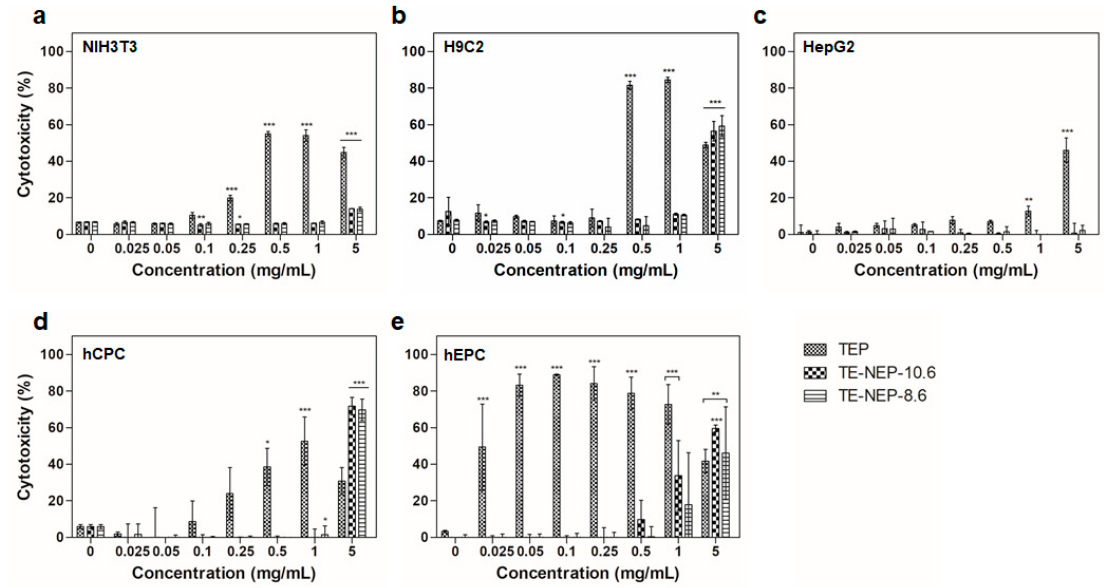
Figure 2. Evaluation of cell viability by MTT assay on ( a ) NIH3T3 cell line, ( b ) H9C2 cell line, ( c ) HepG2 cell line, ( d ) hCPC primary cell, ( e ) hEPC primary cell treated with Turmeric extract powder (TEP) and turmeric extract-loaded nanoemulsion powder with HLB values of 10.6 (TE-NEP-10.6) and 8.6 (TE-NEP-8.6), respectively. Cells were incubated with nanoemulsion samples (0.025, 0.05, 0.1, 0.25, 0.5, 1 and 5 mg/mL) for 24 h. Experiments were repeated 3 times independently. *, **, *** p < 0.05, compared to the control.